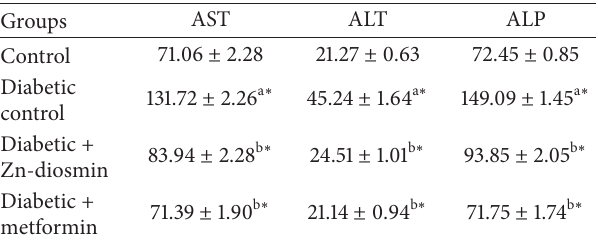
Table 4: Effect of Zn-diosmin complex on levels of activities of AST, ALT, and ALP in the serum of control and experimental groups of rats.